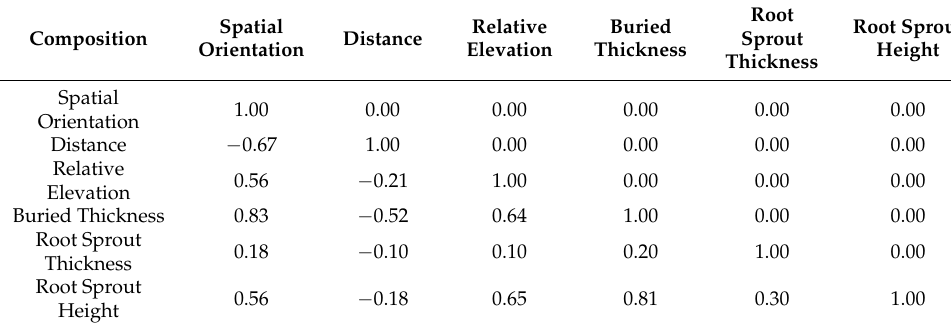
Table 2. Root mutation parameter correlation coefficient